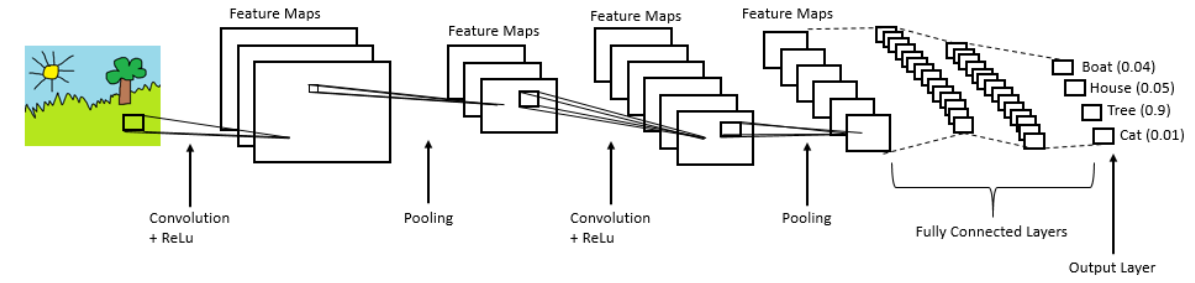
Figure 3. Convolutional neural network framework